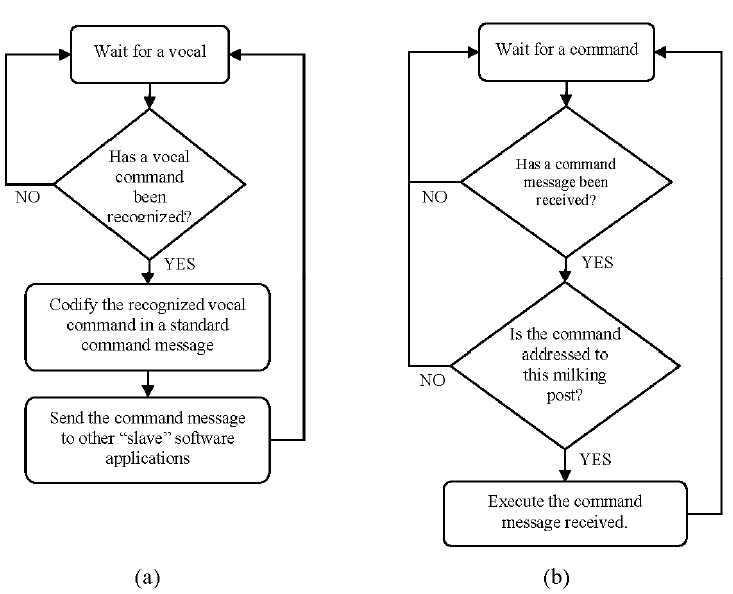
Figure 3. Flow diagrams of the developed software applications. In ( a ) is presented the